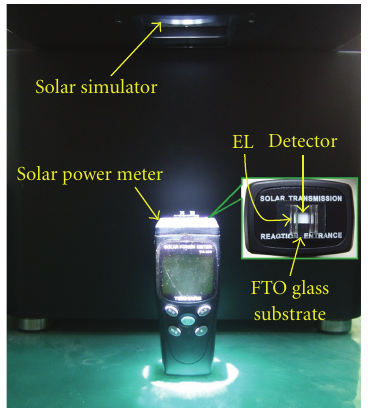
Figure 7: Experimental system for investigating light-harvesting e ffi ciency.